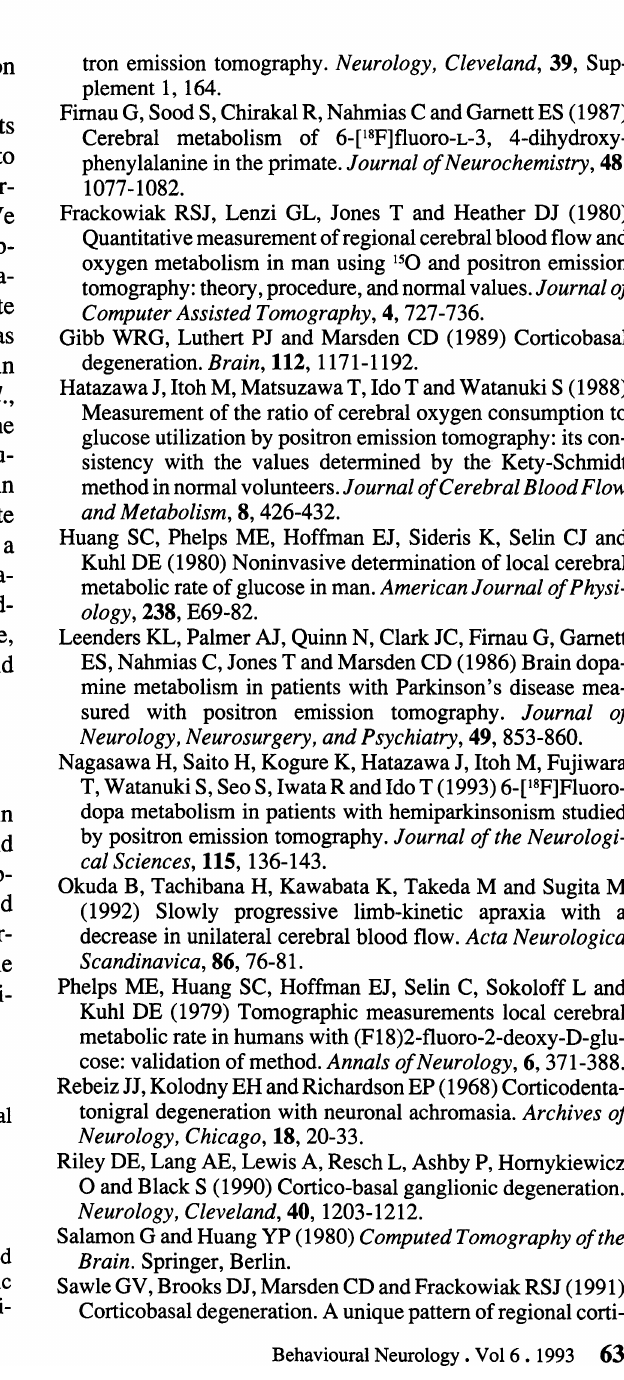
The mean values of target-to-background ratio of the patient were calculated using two brain slices as shown in Fig. 2B, C. n, Number of